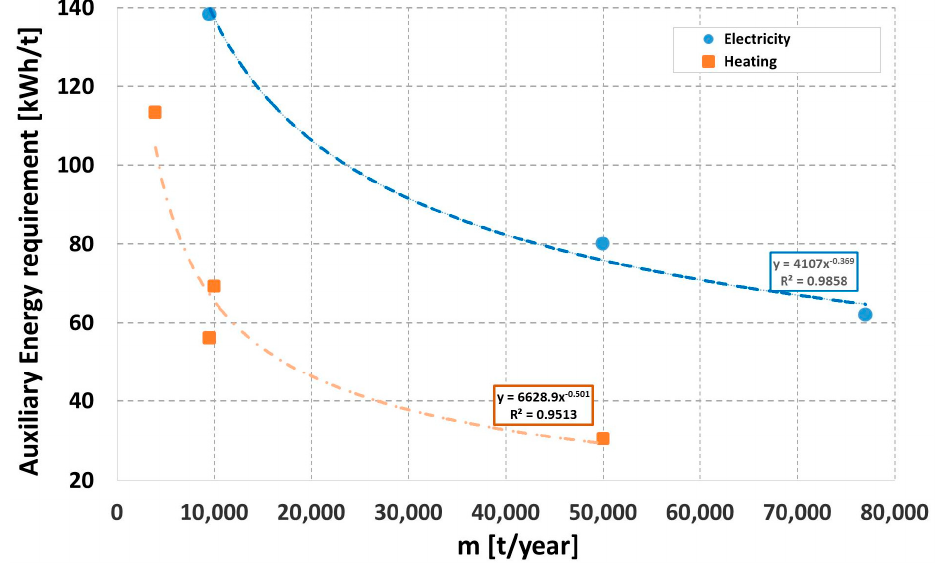
Figure 2. Incidence of auxiliaries’ consumption per biogas production plant size.